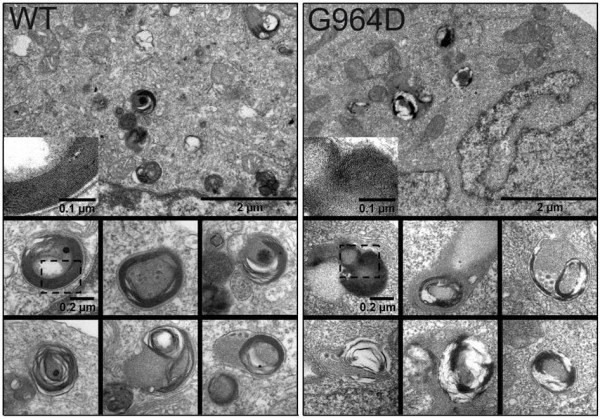
Transmission electron microscopy of stable transfected HEK293-cells. Top: overview of one cell showing cytoplasm, containing mitochondria (light grey) and organelles resembling lamellar bodies (dark grey). Bottom: single ‘lamellar bodies resembling organelles’ in higher magnification. The boxed area is shown in the top image as inset in higher magnification. Note the concentric arrangement of the lamellae in the ABCA3-WT strain. Dark appearing lamellae are mostly wound around a centre of less electron density and appear as parallel lines in the high magnification. In the strain G964D these organelles appear less organized: lamellae are often not arranged perfectly parallel (see inset), and the concentric organisation is not as distinct as in the WT.